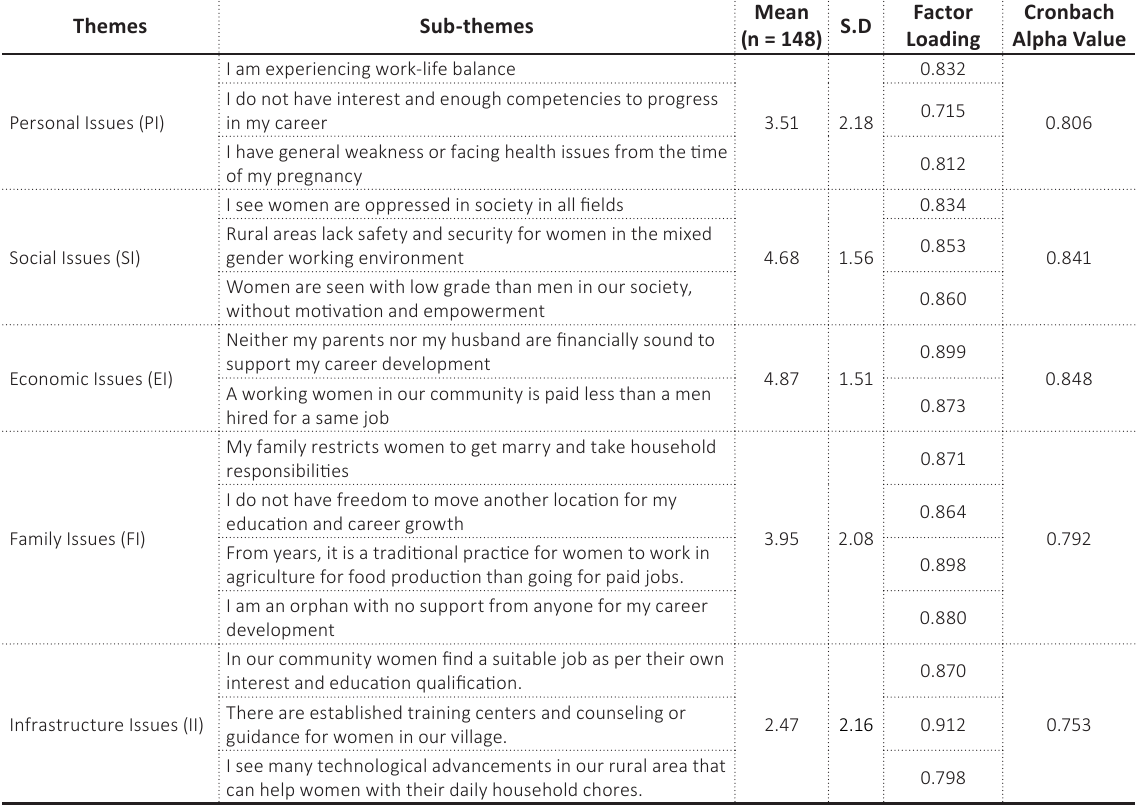
Table 3. Mean, standard deviation, factor loadings and reliability of themes and sub-themes of rural women career